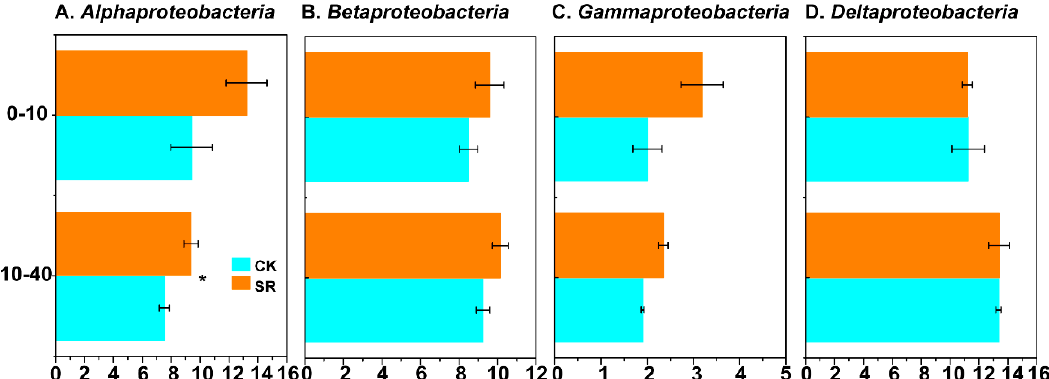
Figure 7. Relative abundances of Alphaproteobacteria ( A ), Betaproteobacteria ( B ), Gammaproteobacteria ( C ), and Deltaproteobacteria ( D ) at depths of 0–10 and 10–40 cm in sugarcane straw retention (SR) and control (CK) treatments. The values at depths of 10–40 cm are weighted means. The heat map specified by “*” shows statistical significance: * p < 0.05.